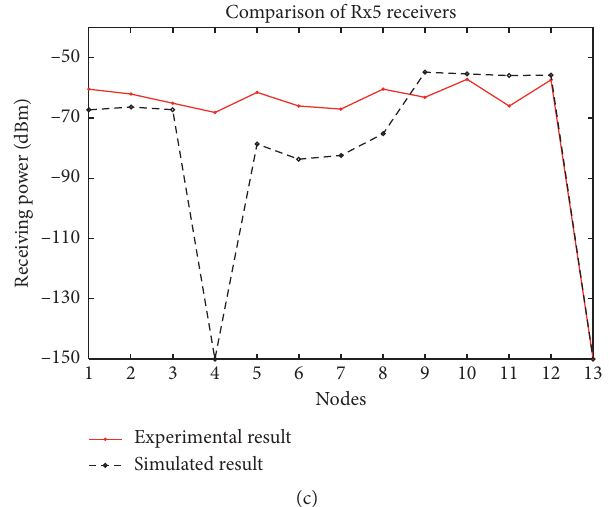
Figure 10: Comparison of simulated and experimental results. (a) Receiving power of nodes of Rx3. (b) Receiving power of nodes of Rx4. (c) Receiving power of nodes of